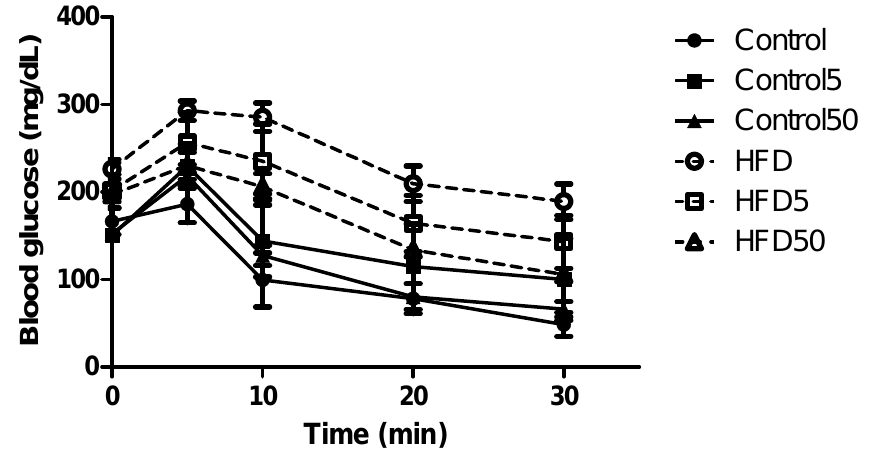
Figure 9. Blood glucose before (0) and after insulin administration in control mice, control mice treated with AERM 5 mg · kg − 1 (Control5) or control mice treated with AERM 50 mg · kg − 1 (Control50), obese mice (HFD), obese mice treated with AERM 5 mg · kg − 1 (HFD5) or obese mice treated with